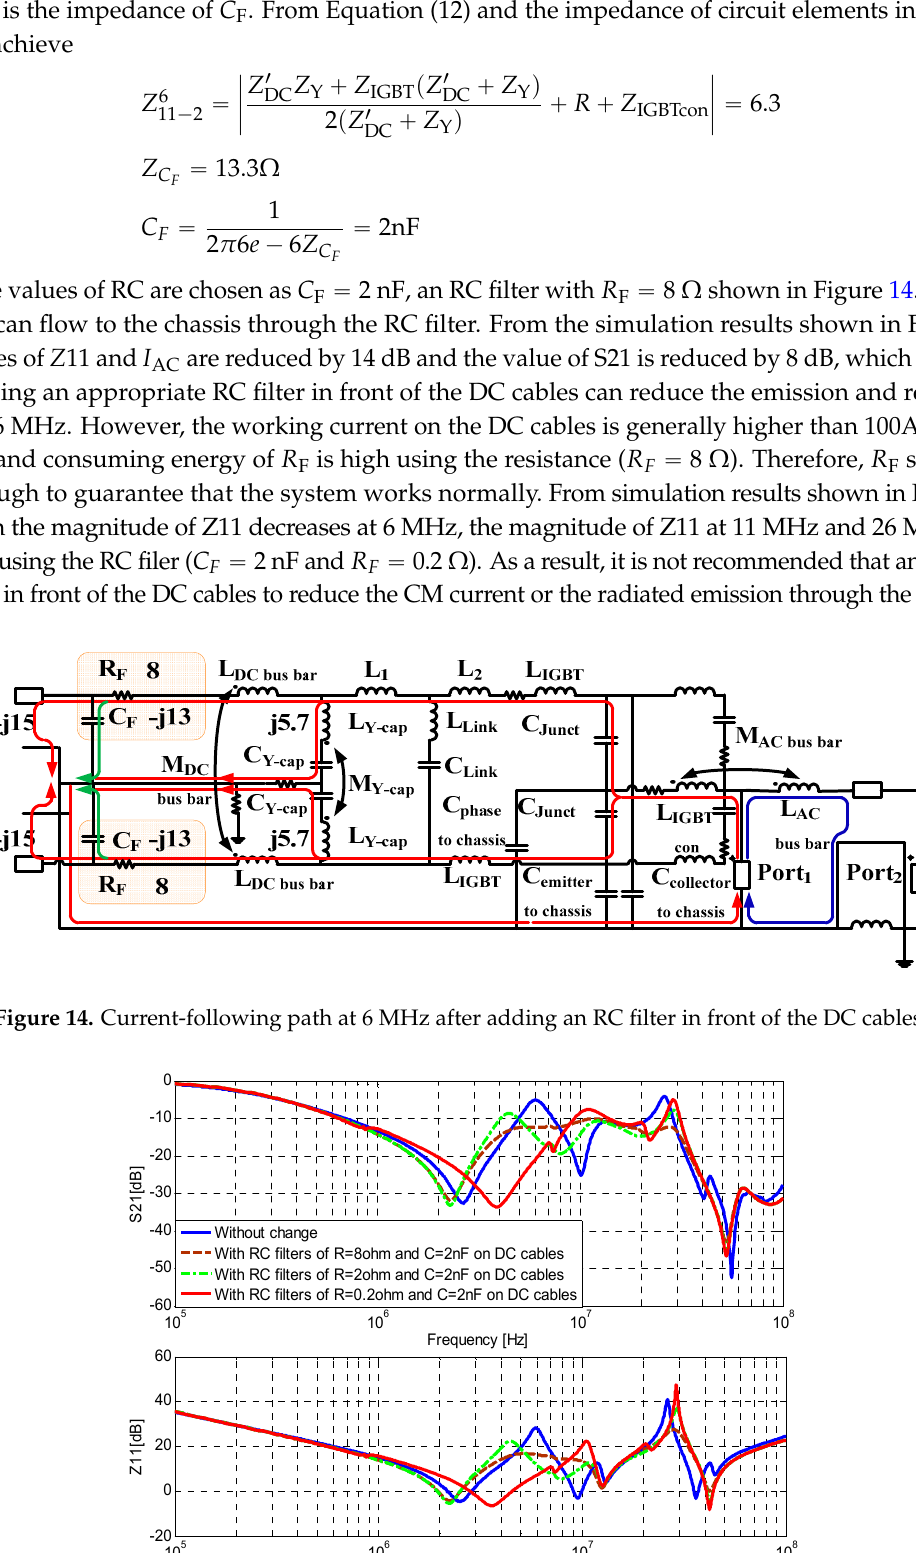
With RC filters of R=0.2ohm and C=2nF on DC cables